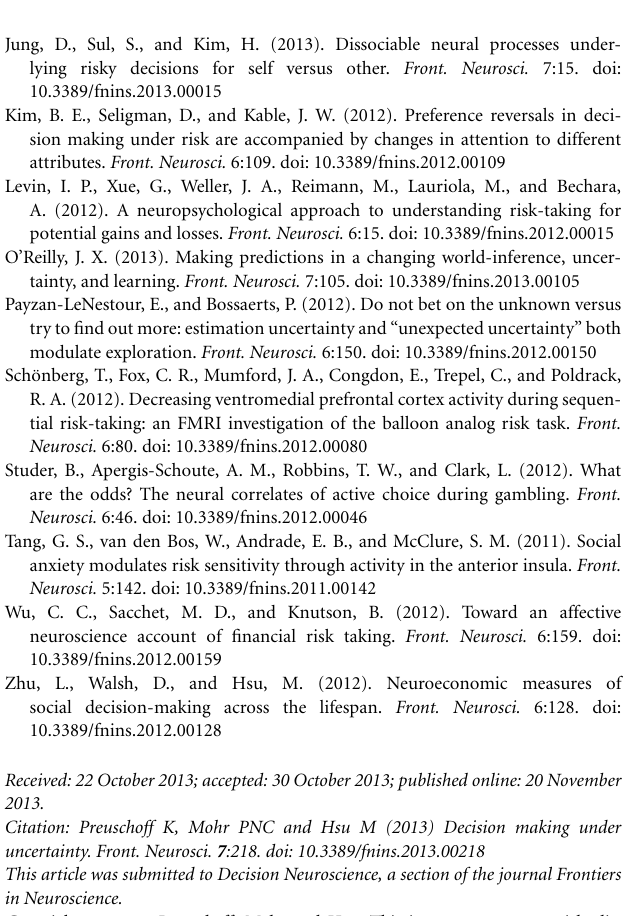
financial theories with the psychological approach which focuses on emotion and